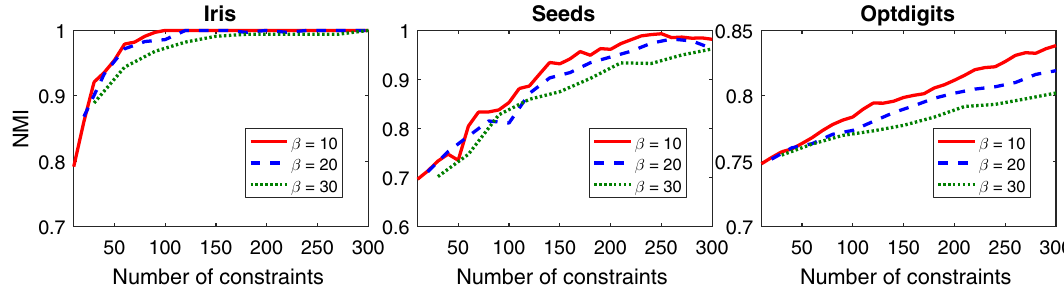
Fig. 11 The effect of the query block size 𝛽 on the performance of Border